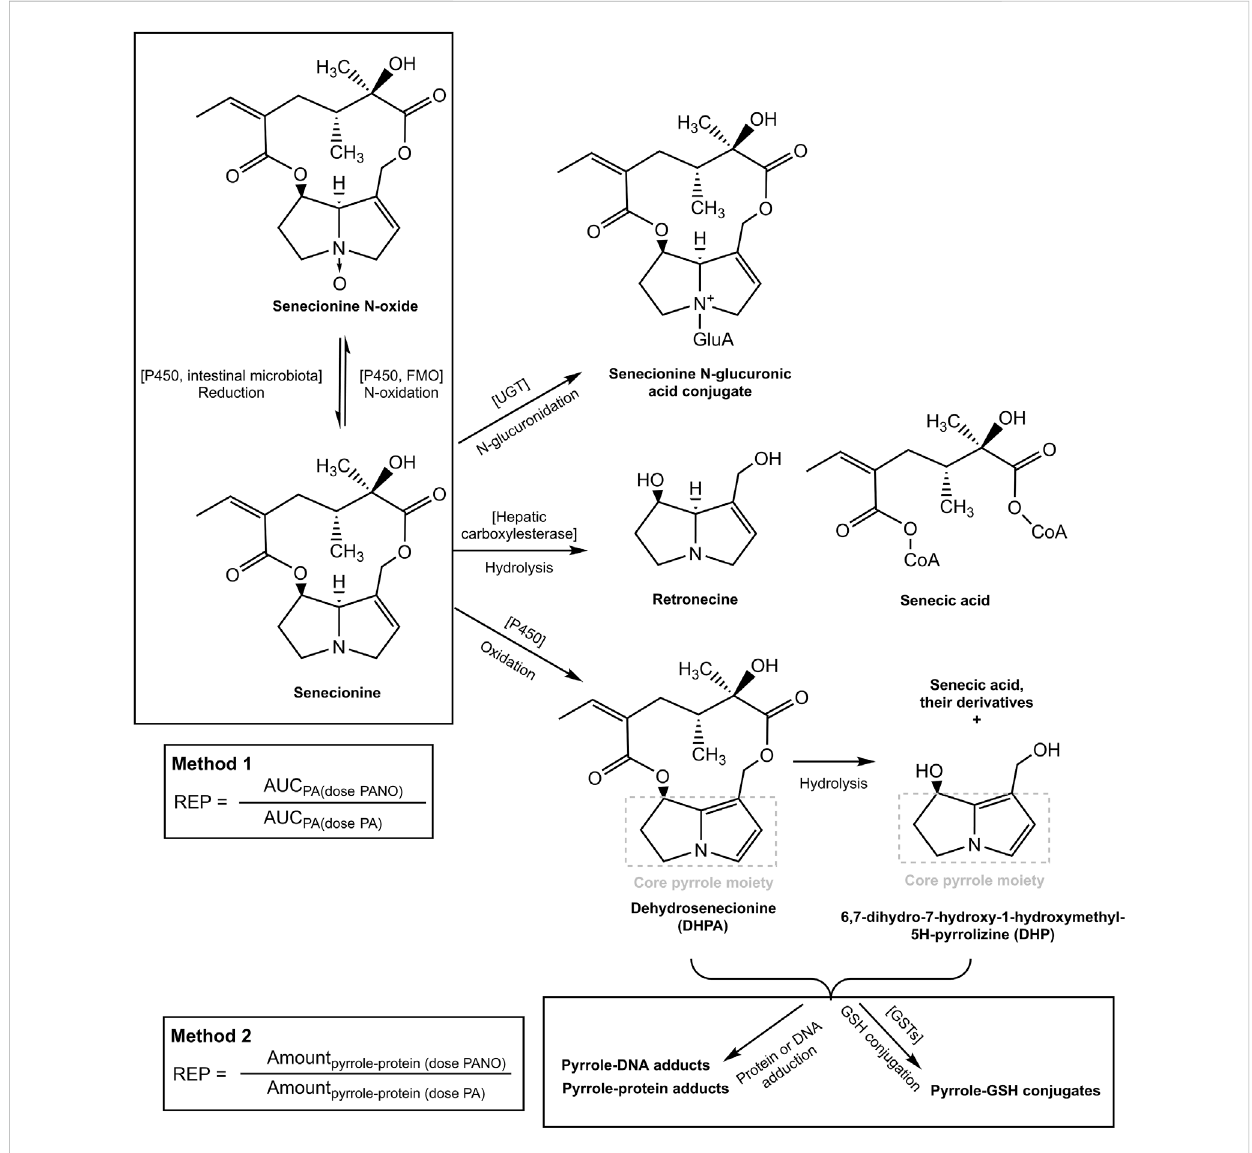
FIGURE 1 Metabolic pathways for SEN and its N-oxide and the two methods for determining the REP value of the PA-N-oxide relative to the corresponding parent PA. The pathways were adapted from our previous publication (Widjaja et al., 2022a).